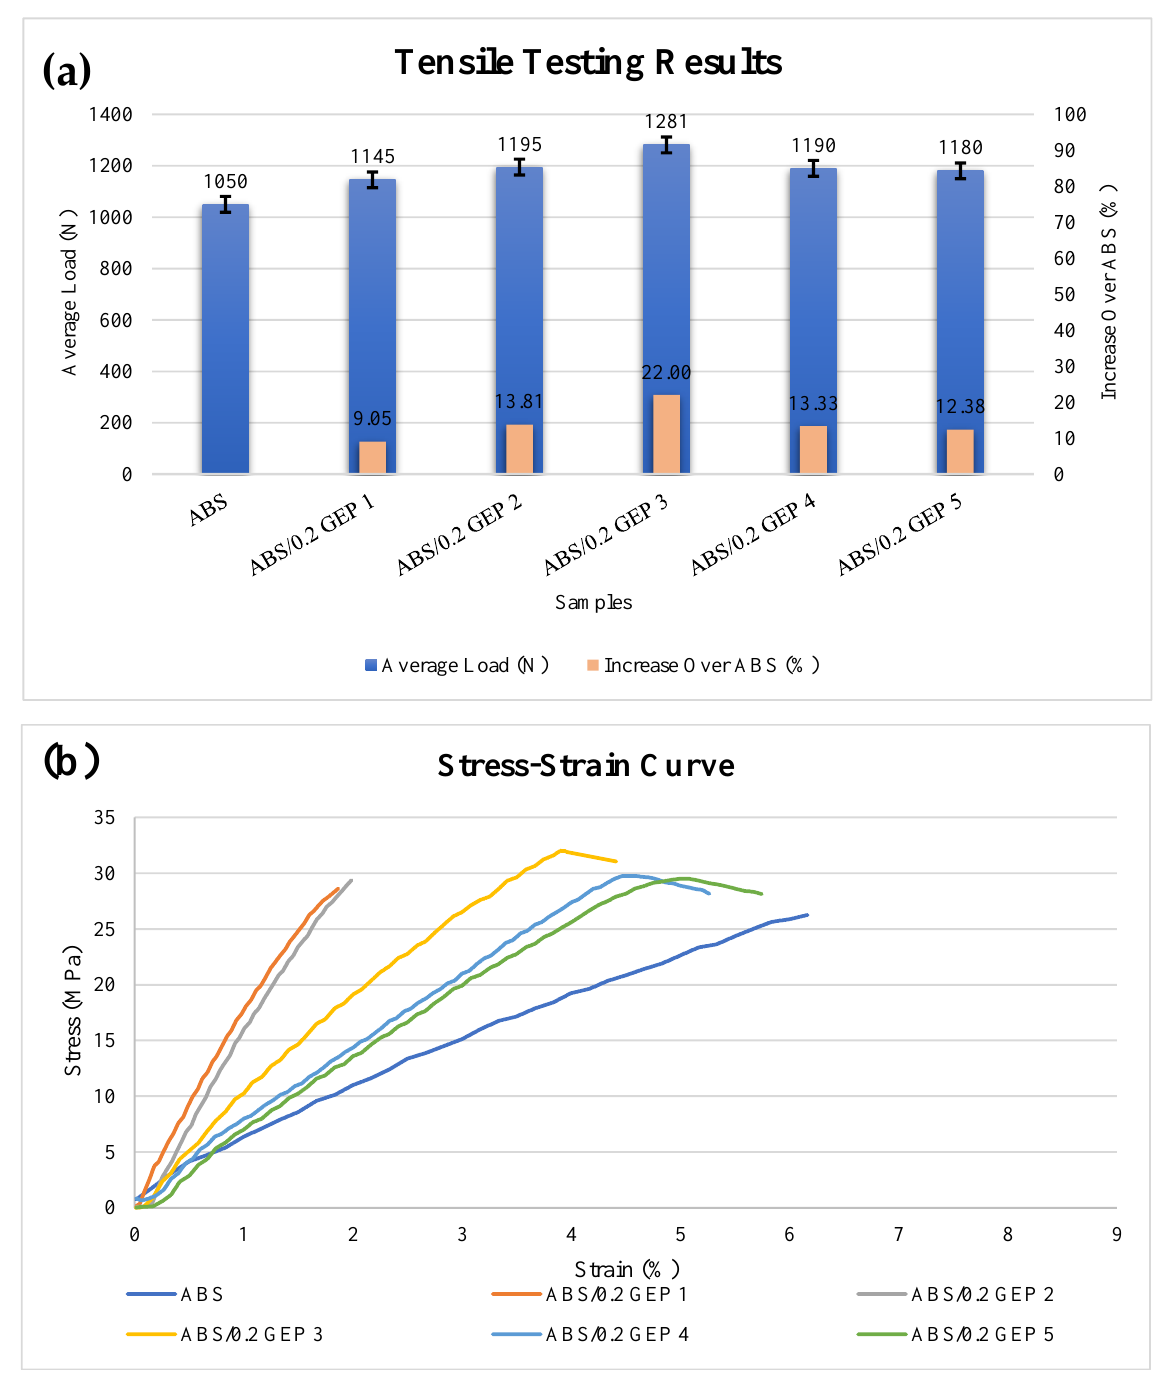
Figure 13. Comparative tensile test results for ABS/0.2 GEP composites: ( a ) results from tensile testing with standard deviation as error bars; ( b ) stress-strain curve.